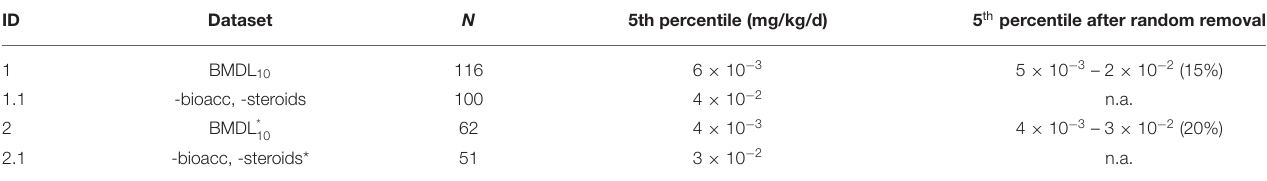
TABLE 2 | Overview on the fifth percentiles obtained from the BMDL 10 datasets: ID 1 BMDL 10 ( N = 116 cmpds); ID1.1 -bioacc, -steroids ( N = 100; reduction by ∼ 15%); ID2 BMDL 10 based on studies with at least three dose groups tested ( N = 62); ID2.1 -bioacc, -steroids ( N = 51; reduction by ∼